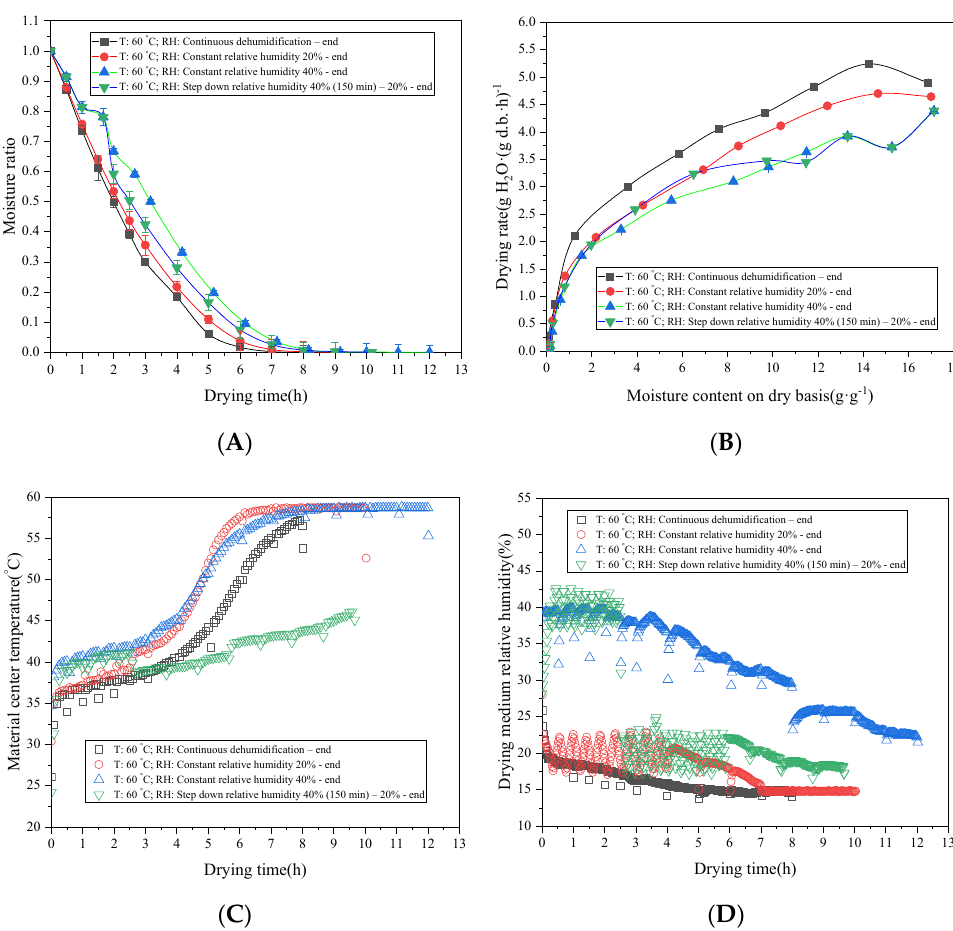
Figure 3. Drying characteristic ( A ), drying rate ( B ), material central temperature ( C ), and drying medium RH value ( D ) of white radish as a function of time under constant RH and step-down RH conditions. Note: velocity at 1.0 m·s − 1 .